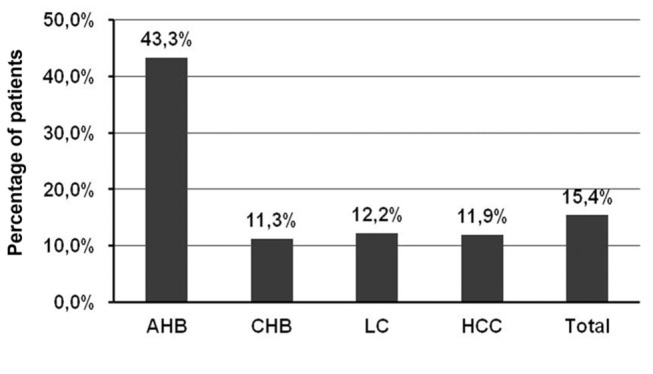
Prevalence of HDV genomes in the HBsAg-positive Vietnamese patients.The prevalence of HDV infection in AHB group was significantly higher in comparison to the CHB, LC and HCC groups (OR =0.19 (CI95 [0.23-0.66]), 0.20 (CI95 [0.08-0.54]), 0.25 (CI95 [0.22-0.71]), respectively; two tailed Fisher’s exact test, p<0.01). Overall, the HDV-prevalence of all patient groups was 15.4% (CI95 [11.1-19.8]) (Total).